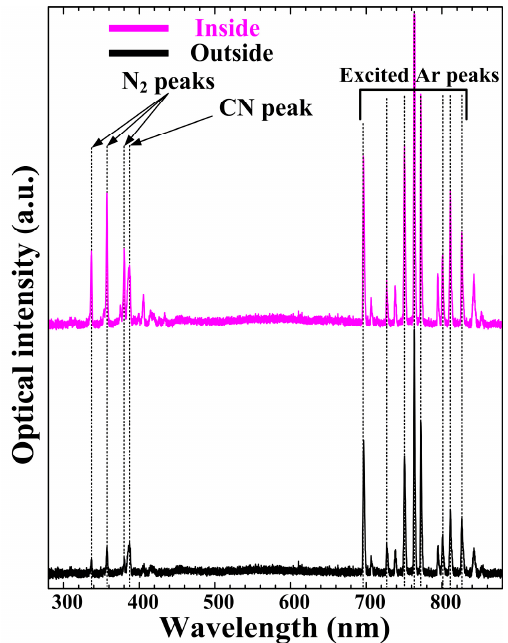
Figure 2. Optical emission spectra using optical emission spectrometer (OES) measured in the nucleation region of novel APPJs, whose insulating substrate holders are placed outside or inside the glass tube.